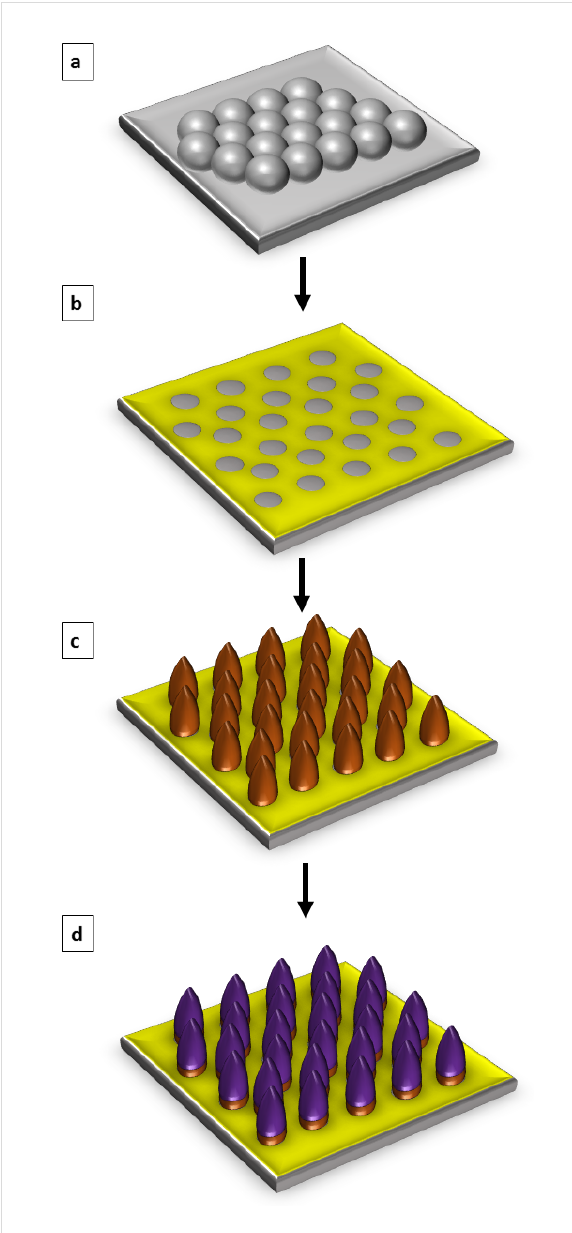
Figure 1: Steps for preparing nanopatterned CMPS-porphyrin hetero- structures. (a) Monodisperse silica spheres were deposited on Si(111) to form a surface mask for particle lithography. (b) After immersion in OTS solution, the microspheres were rinsed away to reveal nanoholes of OTS. (c) With a second immersion reaction, nanodots of CMPS were produced. (d) Reaction with porphyrin produced taller hetero- structures with spatial selectivity for the sites of CMPS